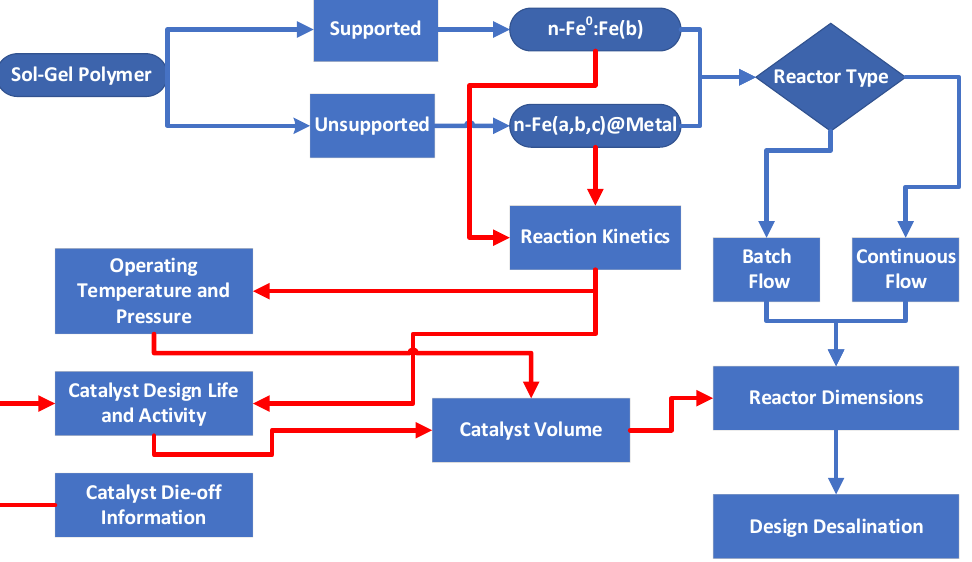
Figure 14. Flow diagram showing the various catalyst parameters considered in this study.